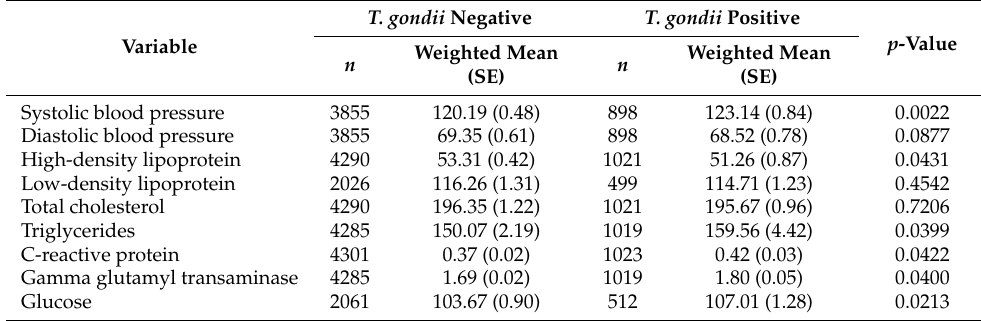
Table 5. Associations between T. gondii (positive/negative) and cardiovascular biomarkers.